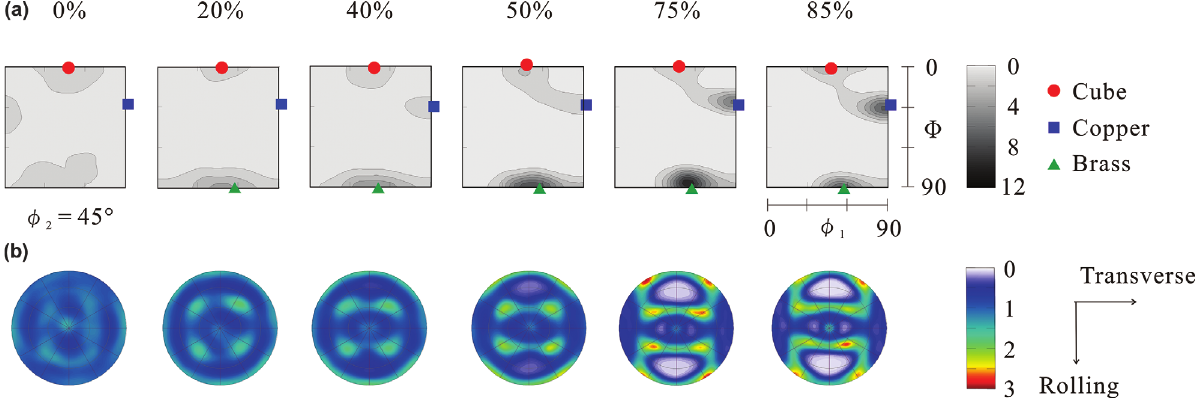
Figure 5: (a) ODFs in φ 2 ¼ 45° section and (b) {100} complete pole figures of cold-rolled pure copper at different reduction levels. The directions of the texture and non-texture components in the pole figures are described in Figure 6.